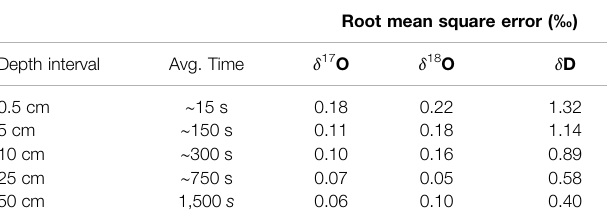
TABLE 3 | Root mean square difference between primary and replicate ice core samples,asafunctionofdepth-averagingwindow. “ Avg.time ” isapproximate time-average corresponding to each depth